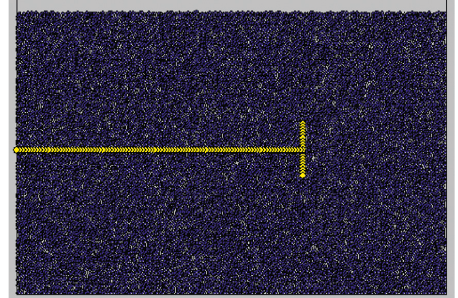
Figure 10: Simulation model of plate